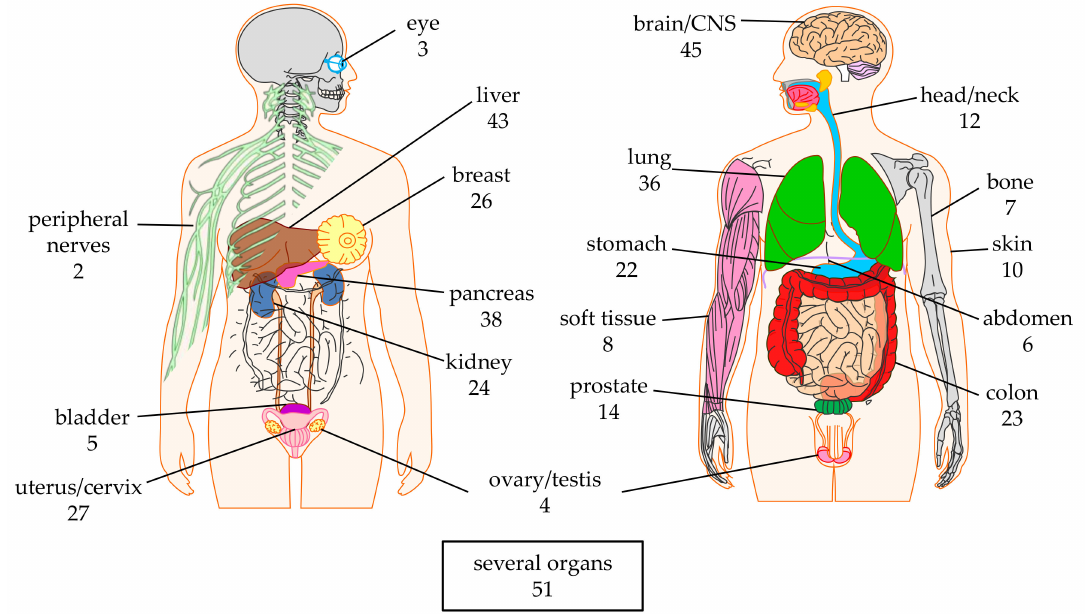
Figure 2. Schematic overview of the organs targeted by CAR-T cells against solid tumors. The numbers indicate the number of clinical trials targeting this organ. Data was extracted from